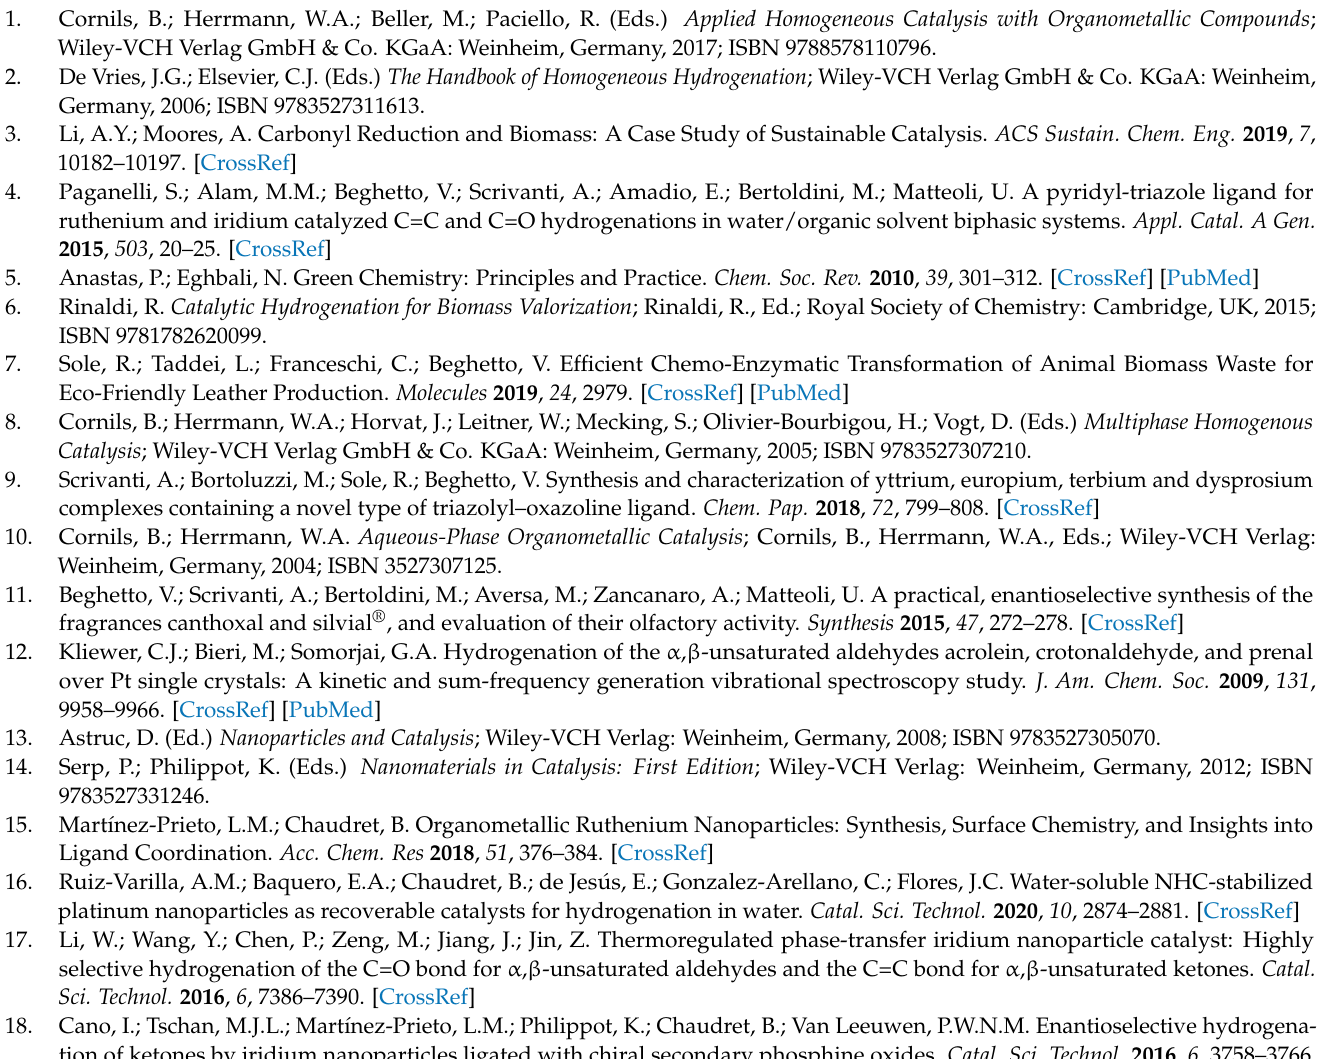
ligand added, Figure S2: TEM (left) and SEM (right) of [Ir(COD)Cl]2/L5 1:0.25, Figure S3: TEM (left) and SEM (right) of [Ir(COD)Cl]2/L5 1:0.75, Figure S4: TEM (left) and SEM (right) of [Ir(COD)Cl]2/L5 1:1, Figure S5: TEM (left) and SEM (right) of [Ir(COD)Cl]2/L6 1:0.5, Table S1: Ligands and solvent screening for the hydrogenation of FUR to